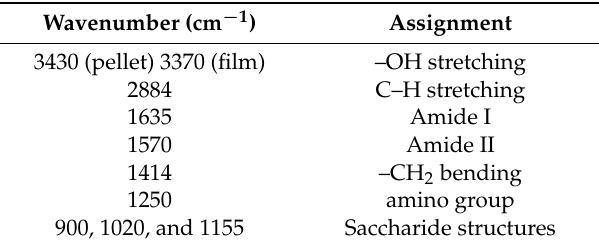
Table 1. FTIR bands of chitosan